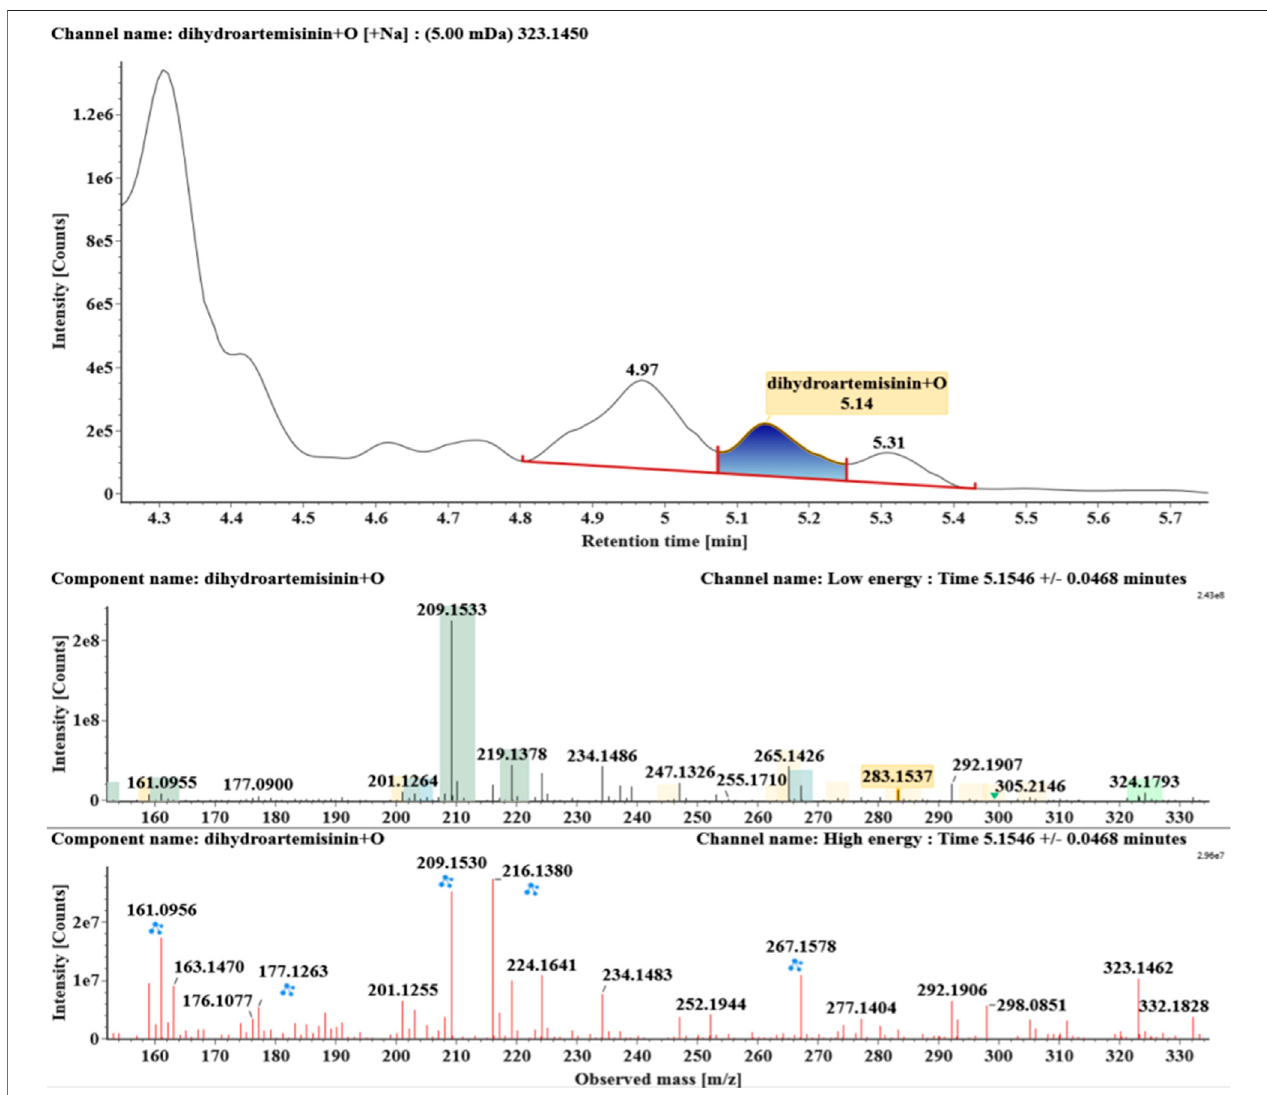
FIGURE 5 | Extracted ion chromatograms and mass spectrometry (MS E ) spectra of M4 .